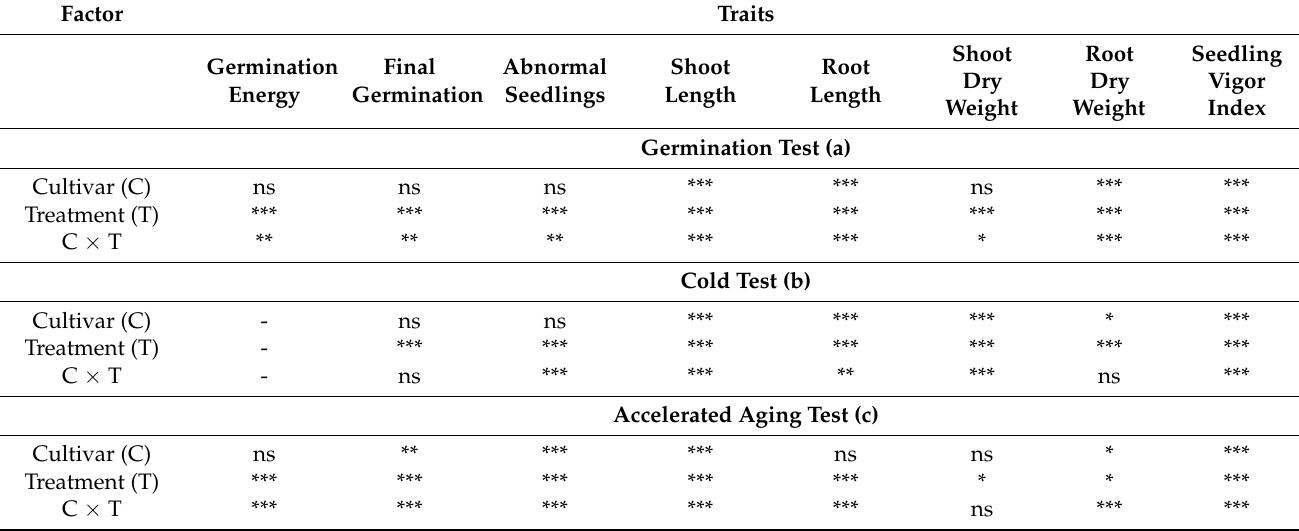
Table 3. Analysis of variance for parameters of two soybean cultivars after applying Bradyrhizobium japonicum and Bacillus megaterium as a single inoculant and co-inoculant during seed bio-priming